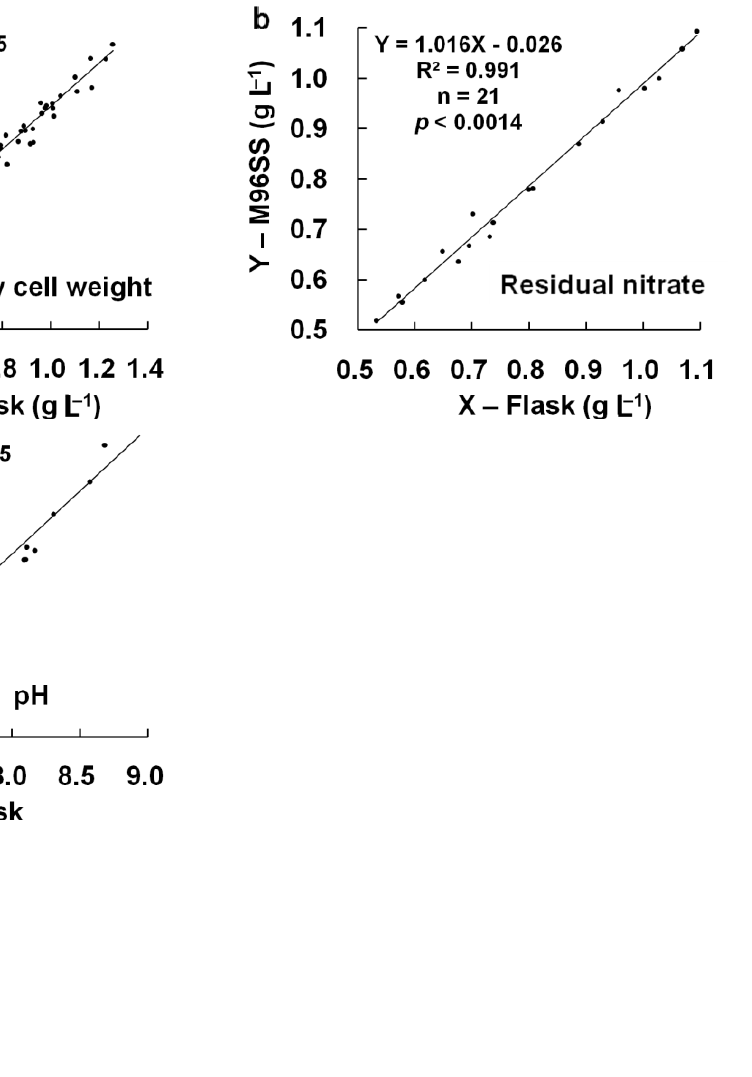
Figure 4. Linear regression analysis of cell growth, residual nitrate, and pH in M96SS versus flask